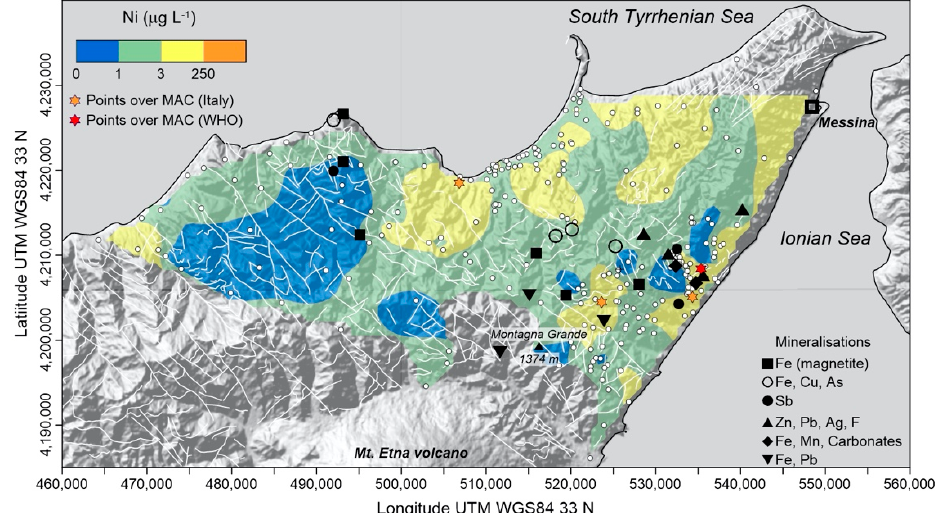
Figure 10. Concentration distribution map of Ni, reporting locations of sampling points (with indication of those exceeding the related MACs) and main mineral deposits; tectonic lineaments (white lines) are also illustrated.